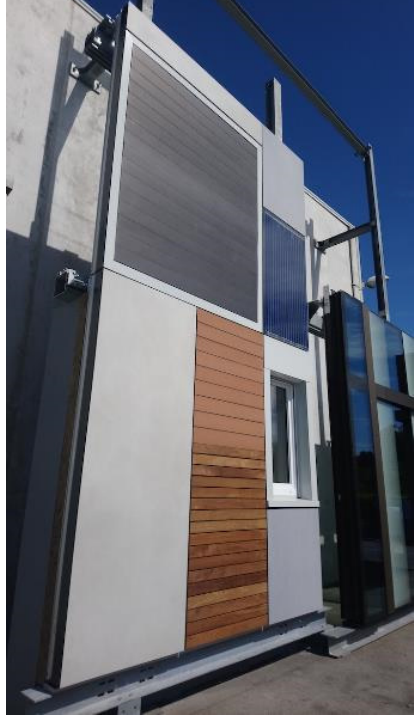
Figure 1. Different finishes and systems of the plug and play façade module.